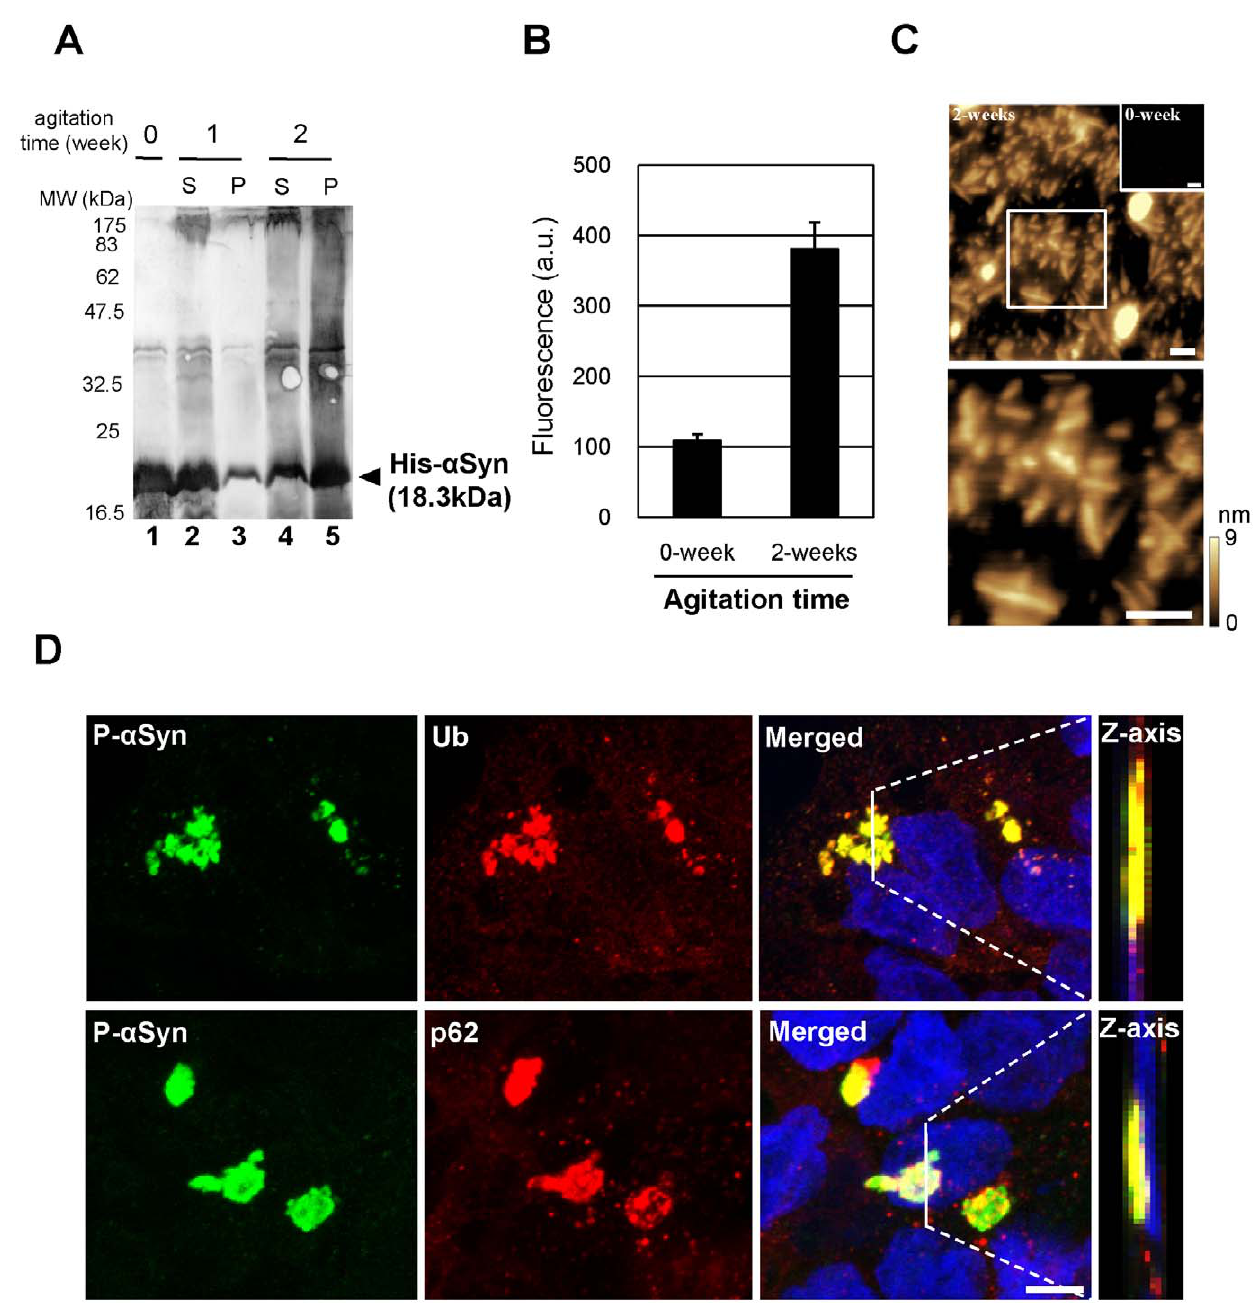
Figure 1. Formation of Lewy body-like a -synuclein inclusions in cultured cells. ( A ) Purified His- a -synuclein protein was agitated for 0–2 weeks (lane 1, 0weeks; lanes 2 and 3, 1week; lanes 4 and 5, 2weeks). Aliquots from each sample were separated into supernatant (lanes 2 and 4) and pellet (lanes3 and 5) fractions. These fractions were subjected to immunoblotting with anti- a -synuclein antibody. Numbers at left are molecular weight markers (MW) in kilodaltons. ( B ) Fibril formation of a -synuclein was measured with ProteoStat, an aggregation detection dye. a.u., arbitrary units. ( C ) AFM images of a -synuclein agitated for 0 or 2 weeks were acquired in air using the dynamic mode. A high-magnification view of the boxed area is shown in the lower panel. The scale on the right represents the height of pixels in the image. Scale bars, 100 nm. ( D ) a -Synuclein inclusions in fibril-introduced HEK293 cells were detected immunocytochemically with anti-phosphorylated a -synuclein (P- a Syn), anti-ubiquitin (Ub), and anti-p62 (p62) antibodies. Confocal images reconstructed in the z-axis along the white lines are shown in the right panel (Z-axis). Blue, DAPI. Scale bar, 10 m m.